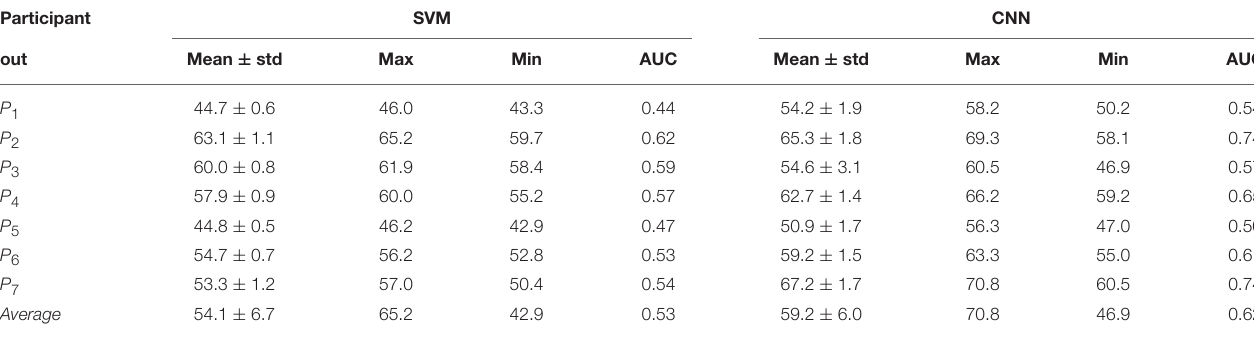
FIGURE 7 | (A) Distribution of classification accuracy achieved with SVM and CNN for the classification experiment leave-one-out participant. The horizontal dotted red line represents the significant chance level or accuracy chance . (B) ROC curves for SVM classifiers for each leave-one-out participant. (C) ROC curves for CNN classifiers for leave-one-out participant.